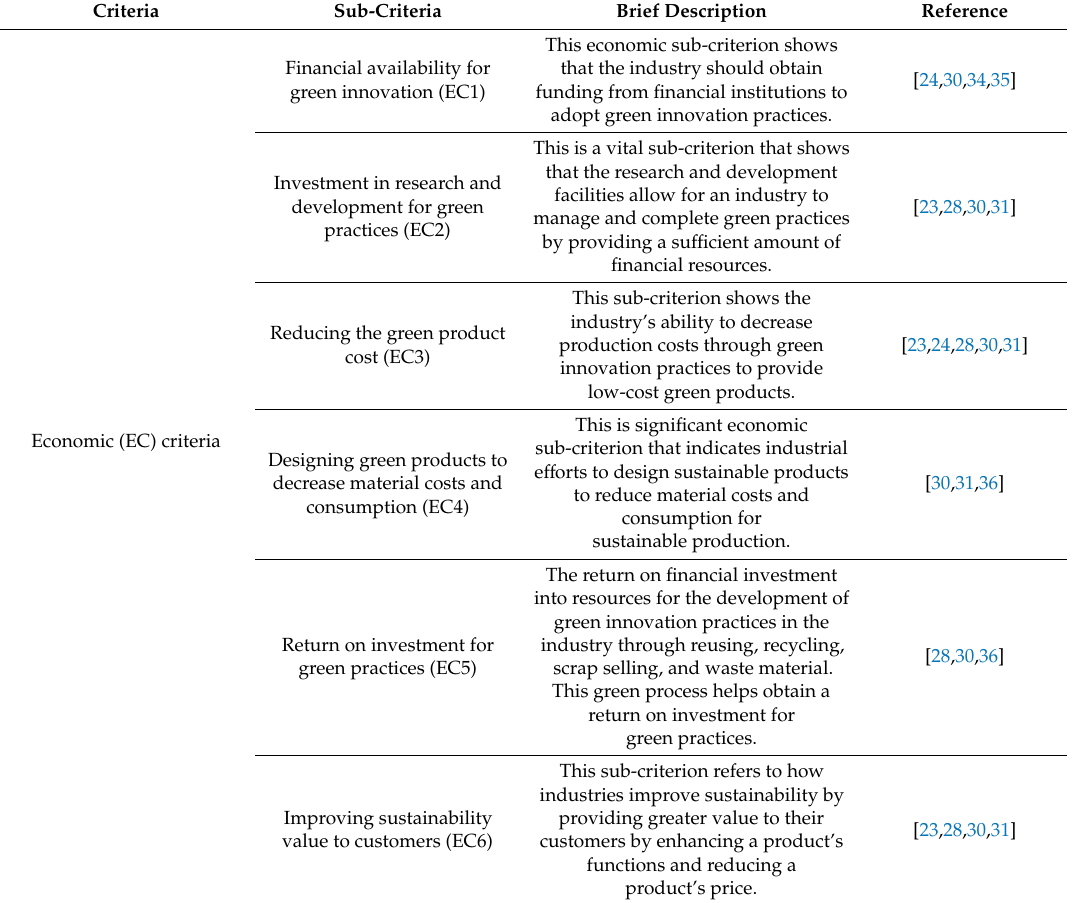
Table 2. Green innovation criteria and sub-criteria for sustainable supply